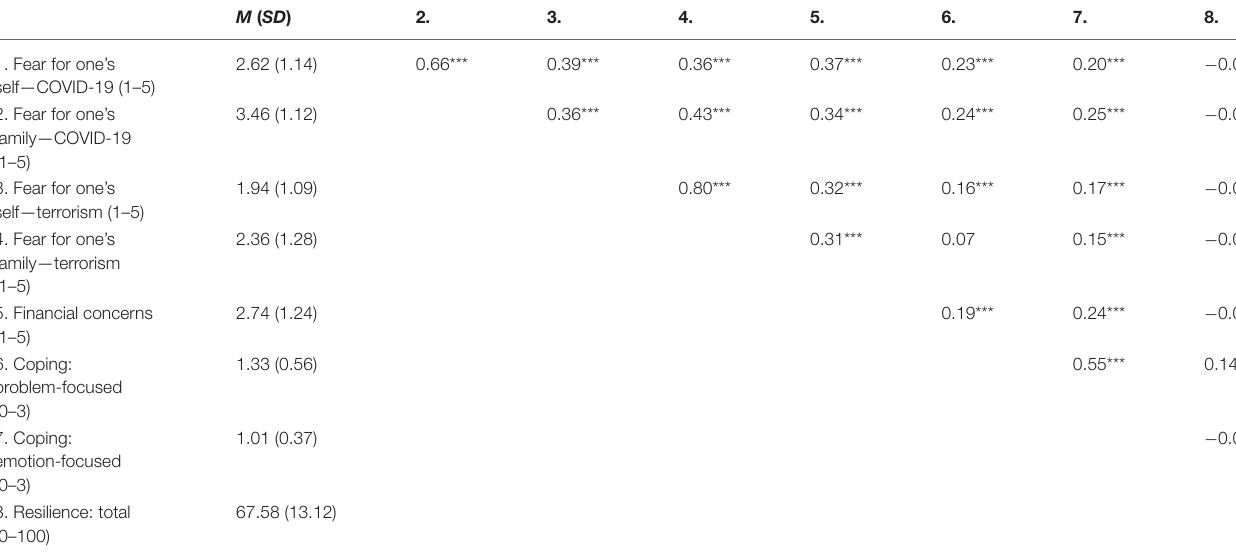
TABLE 3 | Means, standard deviations, and intercorrelations for the research variables ( N =